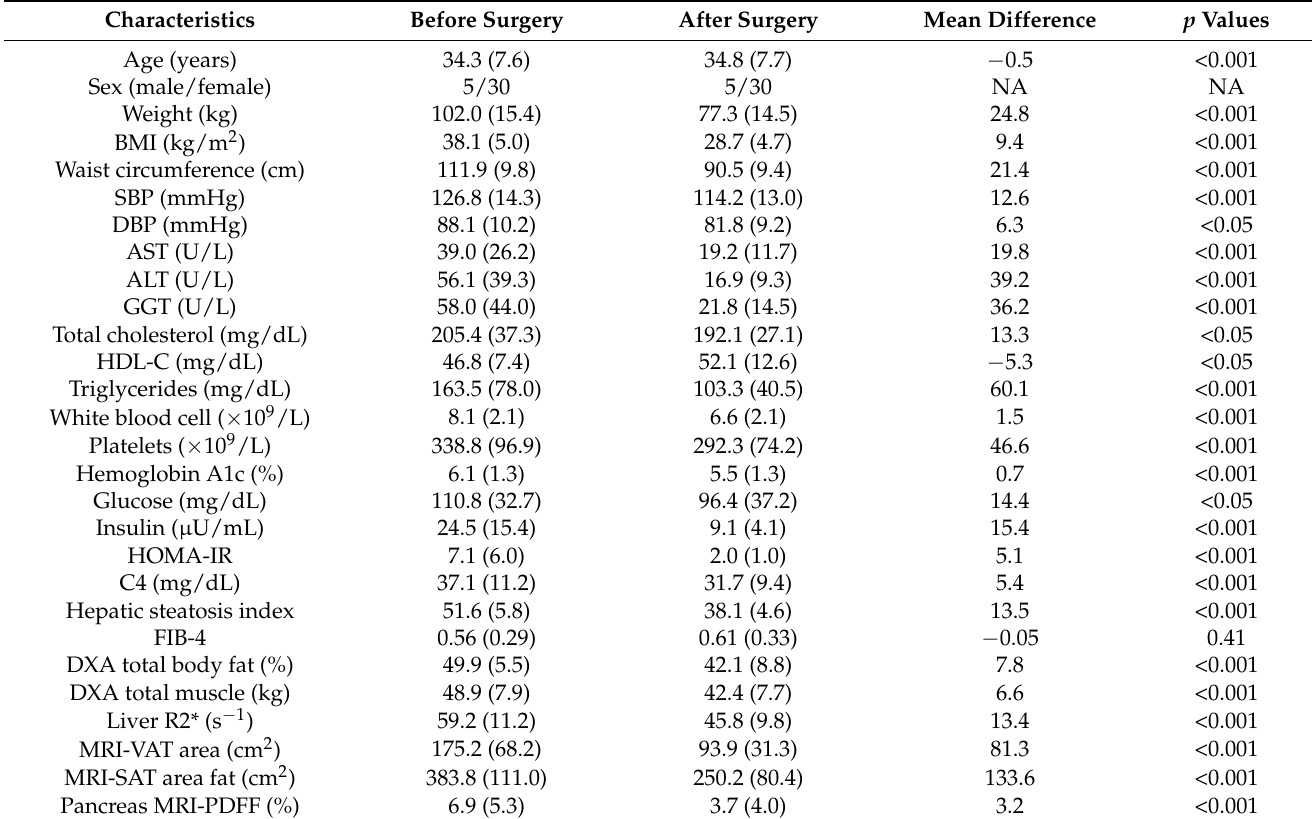
Table 3. Follow-up interval changes in the characteristics of the subgroup of patients who underwent bariatric surgery ( n = 35)